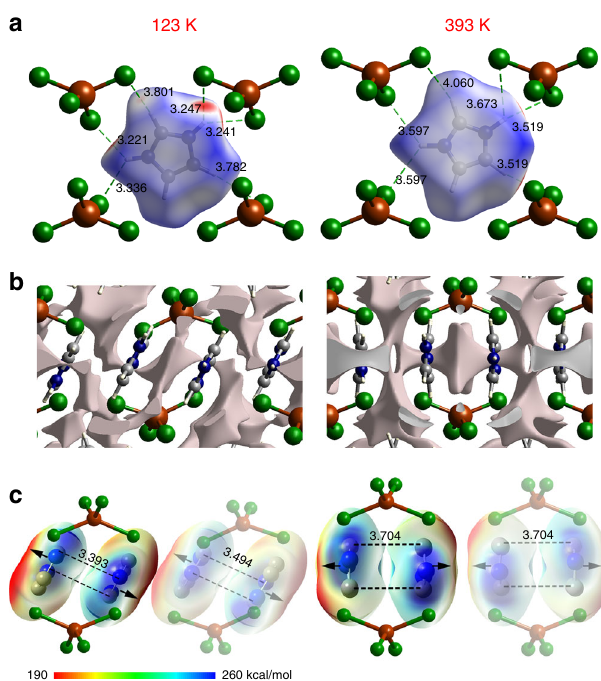
Fig. 5 Comparison of the molecular interactions in the LTP (left) and HTP (right). a The Hirshfeld surface analyses of the Himd + cation in layer A. The red regions of the surface represent molecular contact shorter than the van der Waals distance. The green dotted lines indicate the potential hydrogen- bond interactions involving Himd + cations. b Void surfaces for the Himd + cations in layer A. The large voids around the molecular cation allow it to undergo various types of molecular motion. c The electrostatic repulsions between the dimer structure of molecular cations in layer A. The electrostatic potential distribution of two cations of the dimer in layer A are shown with isovalue 0.004 a.u. The black arrows denote the dominating electrostatic repulsions on the molecular cations. Notably, the electrostatic repulsions unevenly work on the molecular planes of cations when the cations are in an offset stacking. The molecular cations in different crystallographic planes are drawn in